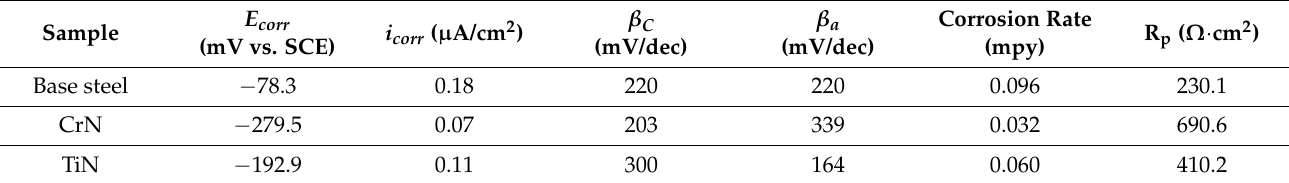
Figure 10. Corrosion behavior of various specimens in the PDP test. Table 5. The parameters determined by Talfel analysis for various specimens.